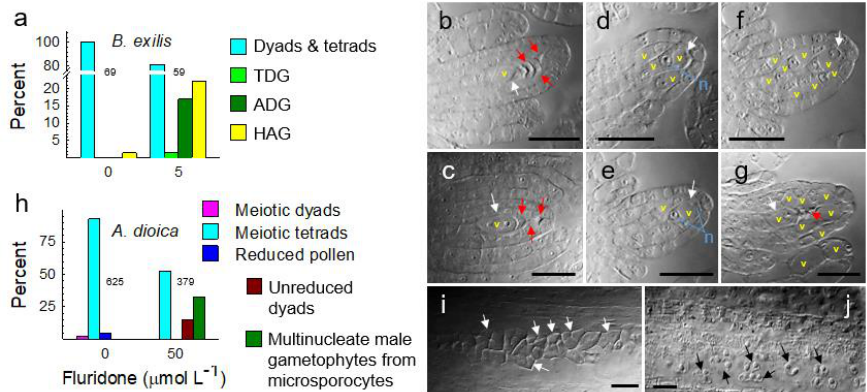
Figure 12. Fluridone induced unreduced gametophyte formation in ovules of Boechera exilis and anthers of Antennaria dioica : ( a ) percentages of ovules that produced Taraxacum (TDG), Antennaria (ADG) and Hieracium (HAG) types of gametophyte formation in ovules of sexual B. exilis when treated with fluridone; ( b , c ) tetrad and 2-nucleate sexual gametophyte in control pistils; ( d , e ) 1 and 2-nucleate ADGs in ovules of fluridone treated pistils (apospory is also occurring in these ovules); ( f ) 2-nucleate ADG and HAG formation in the same ovule of a fluridone treated pistil; ( g ) formation of multiple 1–2 nucleate HAGs in the same ovule of a fluridone treated pistil (this pistil had also successfully completed meiosis and was forming a vacuolate sexual gametophyte (white arrow)); ( h ) fluridone induced ameiotic male gametophyte formation from microsporocytes in young anthers of stem-cultured dioecious A. dioica ; ( i ) normal microspore tetrads in anthers of control A. dioica plants; ( j ) multinucleate and vacuolate ameiotic 1–3 nucleate pollen grains that formed directly from microsporocytes in A. dioica anthers from stems that were cultured in fluridone amended medium. Numbers of informative ovules or anther meiocytes analyzed appear next to treatment bars in ( a ) and ( h ). Pooled chi-squares were significant ( p < 0.001). red arrows, degenerating haploid megaspores; n, nucleus; v, vacuole; cytology bars, 20 μm.